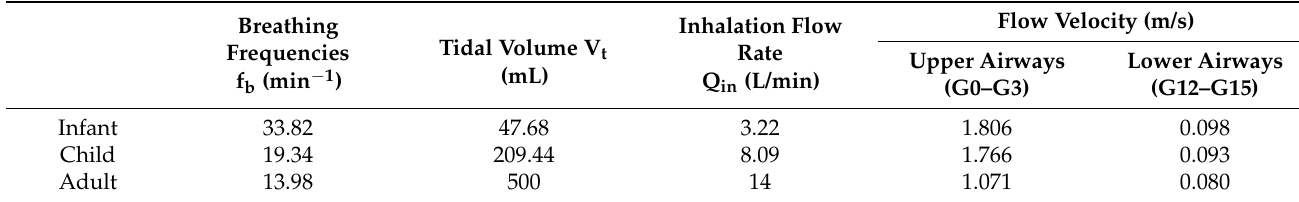
Table 2. Breathing parameter as a function of age based on the human activity